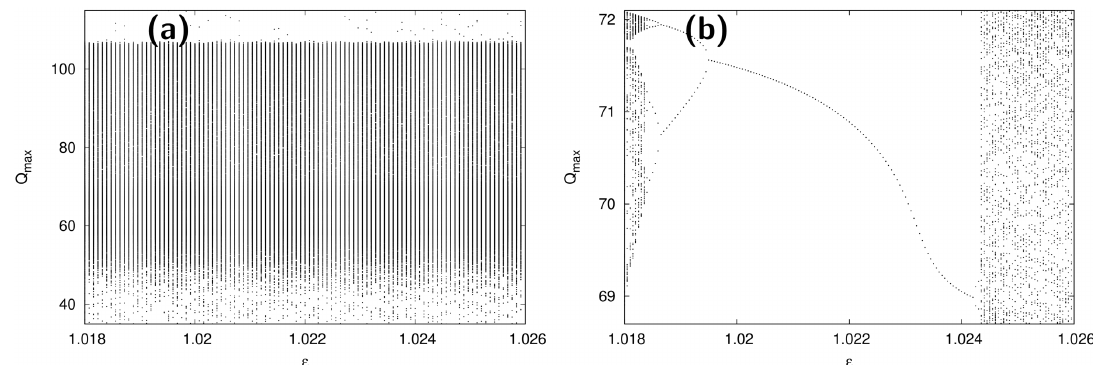
Figure 4. ( a ) Logistic map for Q max without including higher-order effects. Complex picture, natural consequence of explosive chaotic behavior; ( b ) Logistic map for Q max including higher-order effects. One can observe a window without chaos around (cid:101) =